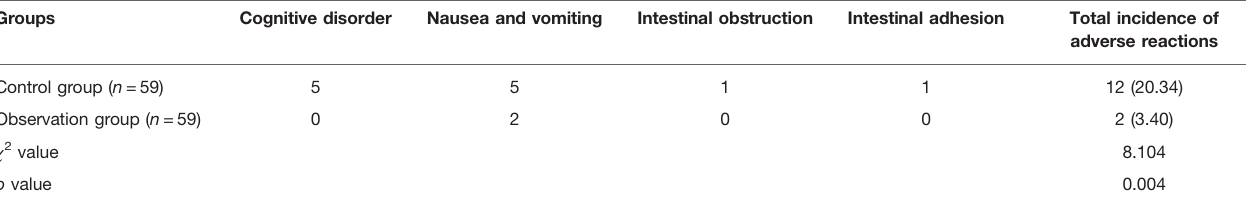
TABLE 2 | Comparison of adverse drug reactions between the two groups during treatment ( n ,%).